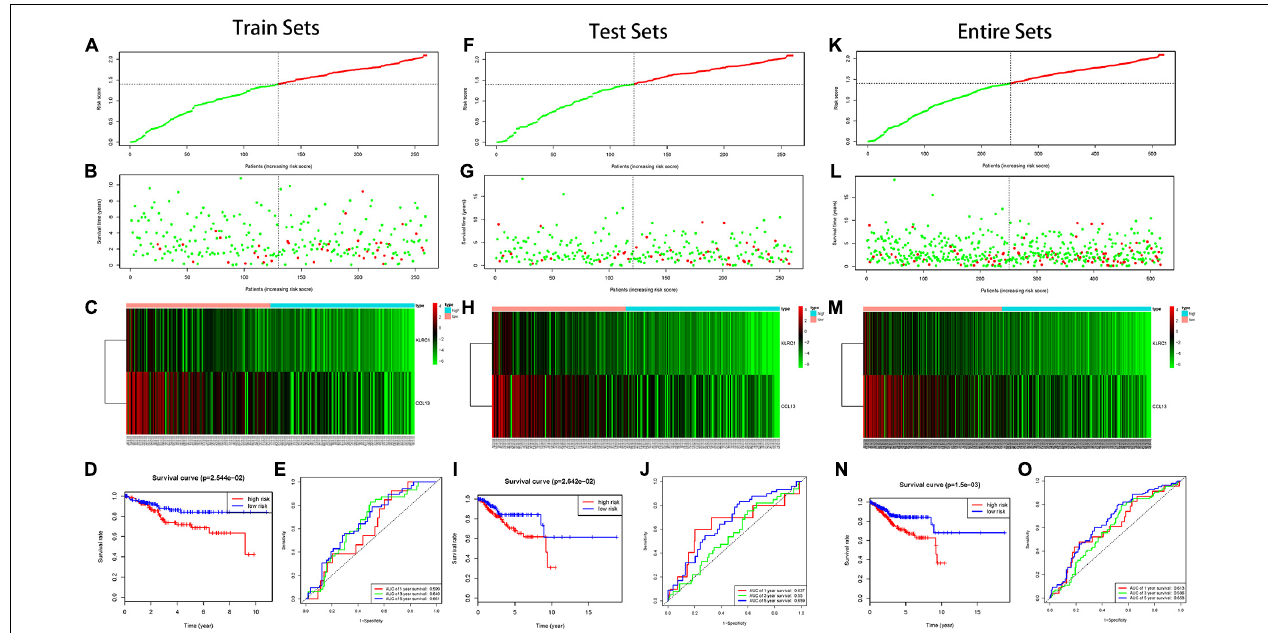
FIGURE 5 | Construction of the IRPS. (A–C) The distribution of Risk score, survival status and expression of 2 hub genes in training set. (D) Kaplan-Meier survival curves of overall survival between high-risk and low-risk patients in training set. (E) 1-, 3-, and 5-year ROC curve of the predictive power of the IRPS in training set (F–J) . (K–O) display similar analyses which were conducted in the testing set and the entire set.